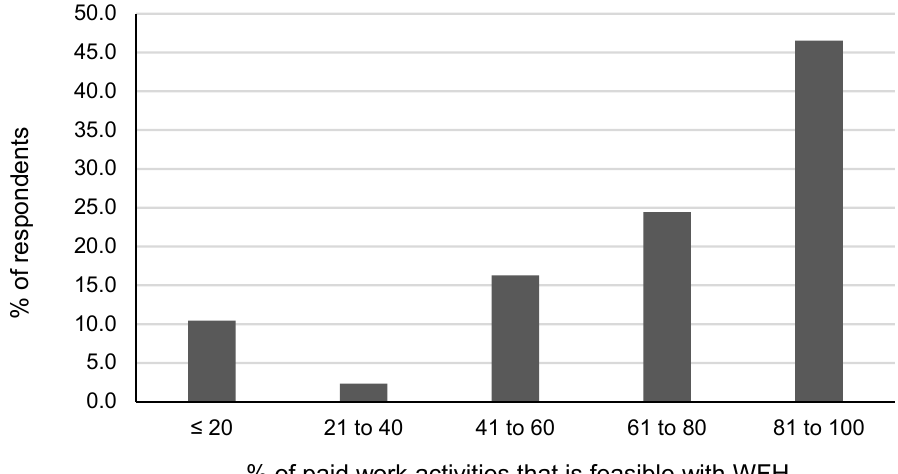
Figure 7. Future preference for WFH after the pandemic. To conclude, the associations between gender and the respondents’ self-reported work productivity, overall WFH satisfaction and future preference for WFH were exam- ined. The Fisher’s exact test results in Table 6 show that there is a statistically significant association between: (i) gender and productivity at 10% significance level ( p = 0.090), and (ii) gender and overall satisfaction with WFH at 5% significance level ( p = 0.044). The cor- relations between the respondents’ self-reported work productivity, overall WFH satis- faction and future preference for WFH, on the other hand, are all statistically significance at p < 0.01 level where the tests were performed on the total sample and the two gender groups (Table 7). These statistically significant positive correlations suggest that as the respondents’ perceived level of work productivity increases, their overall WFH satisfac- tion increases and they would welcome WFH arrangement post-pandemic, and vice versa. Overall, the results show that the correlation between overall WFH satisfaction and future preference for WFH is rather strong ( r = 0.621), this is followed by moderate corre- lation between work productivity and future preference for WFH ( r = 0.572), and lastly between work productivity and overall satisfaction with WFH ( r = 0.490). The former two correlations are indeed even stronger for the male group and the correlation coefficients are r = 0.663 and r = 0.639, respectively.